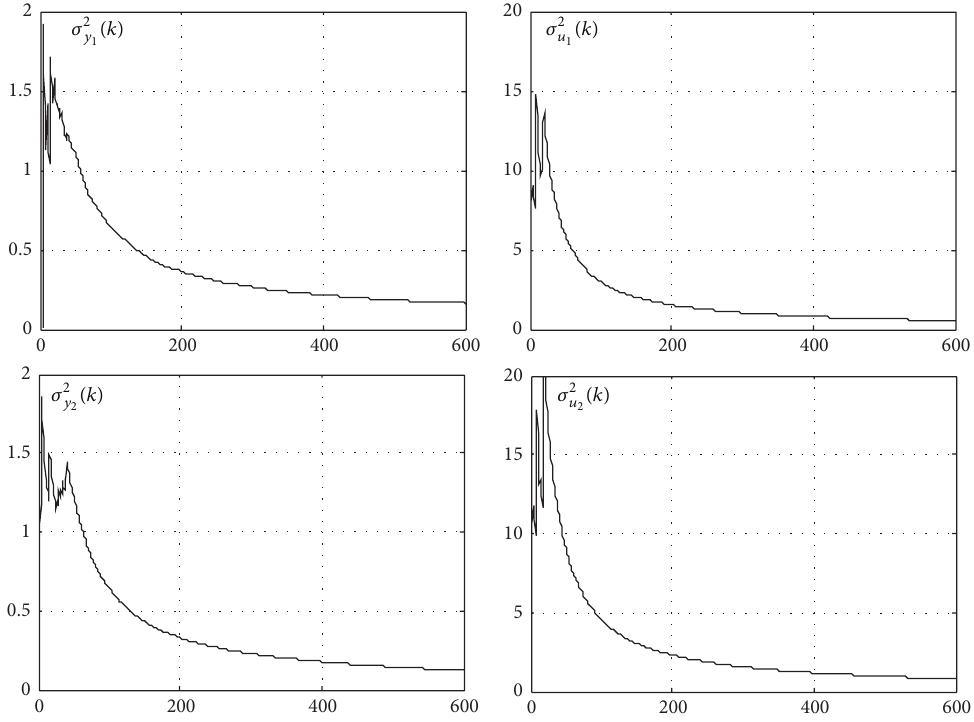
(𝑘) and 𝜎 2 (𝑘) and the control laws variances 𝜎 2 𝑦 2 1